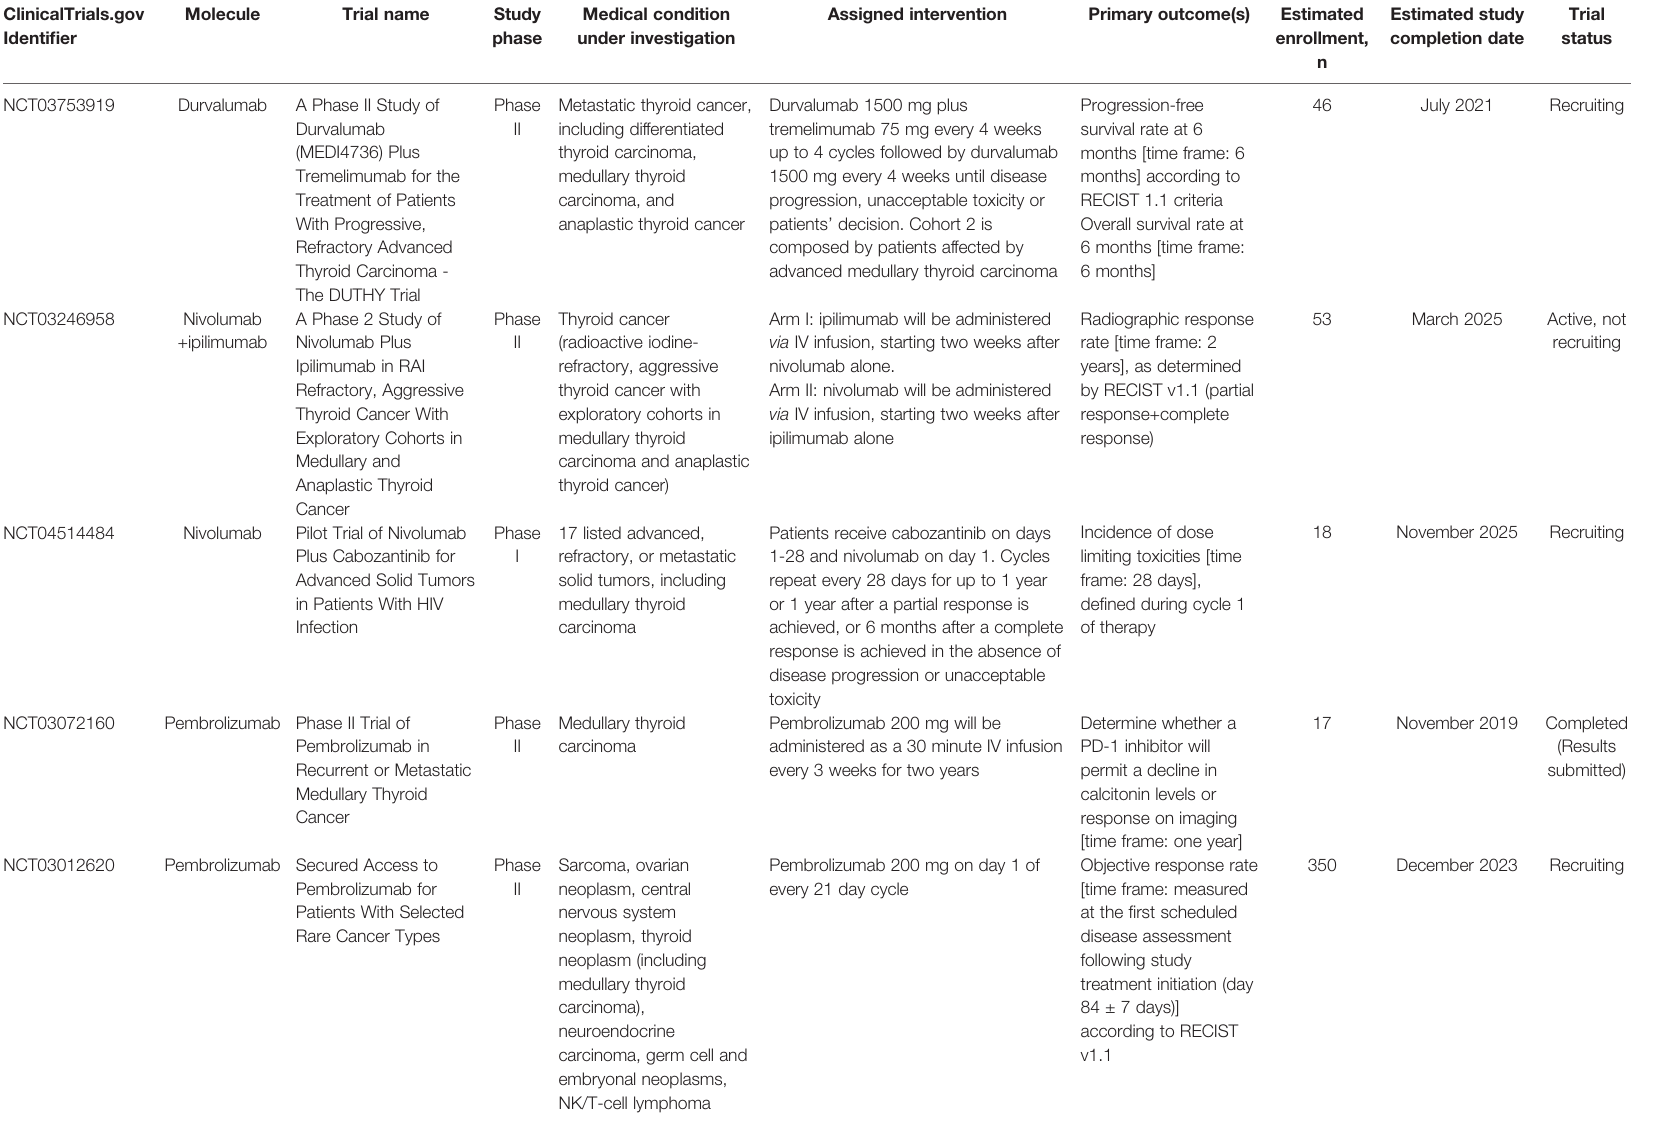
TABLE 2 | Registered clinical trials evaluating FDA-approved immune checkpoint inhibitors in medullary thyroid carcinoma. ClinicalTrials.gov Identi fi